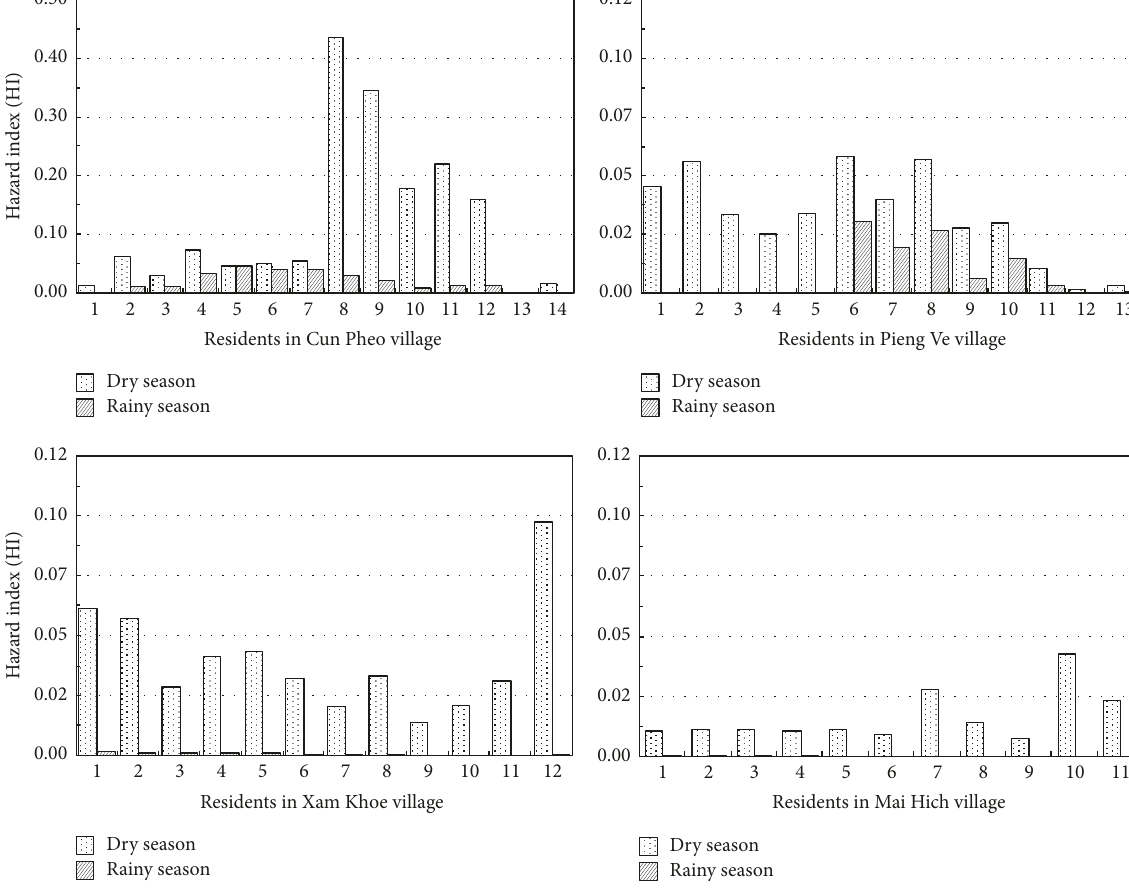
Figure 4: Hazard index of residents living in Mai Chau in dry and rainy